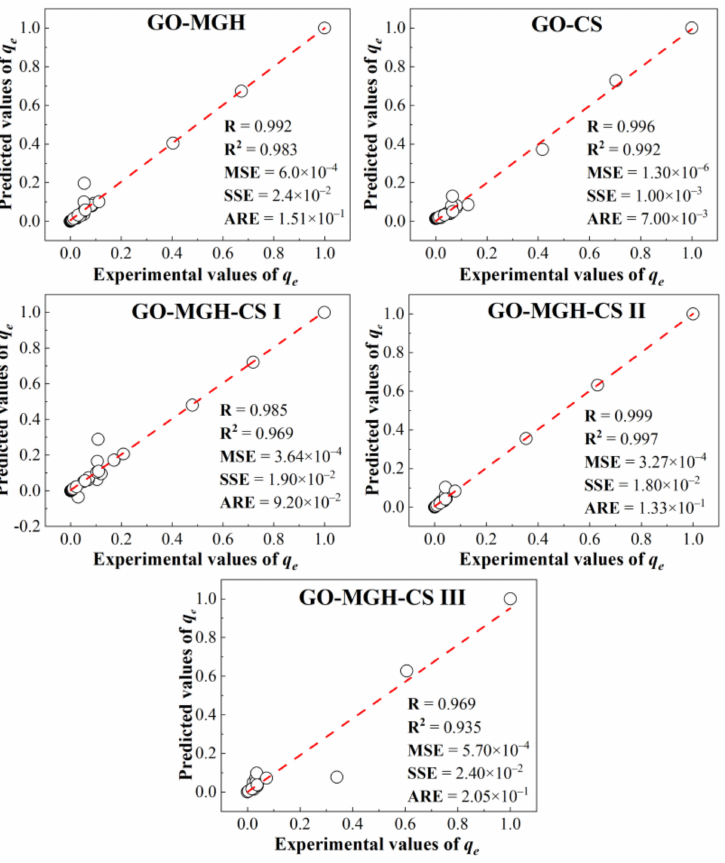
Figure 10. Comparison of the experimental data with the data predicted by